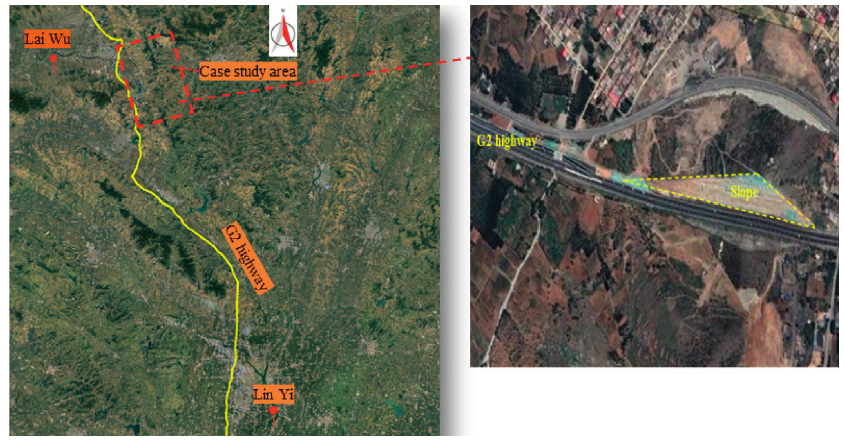
Figure 1: The relationship between slope and geographical position of the highway.